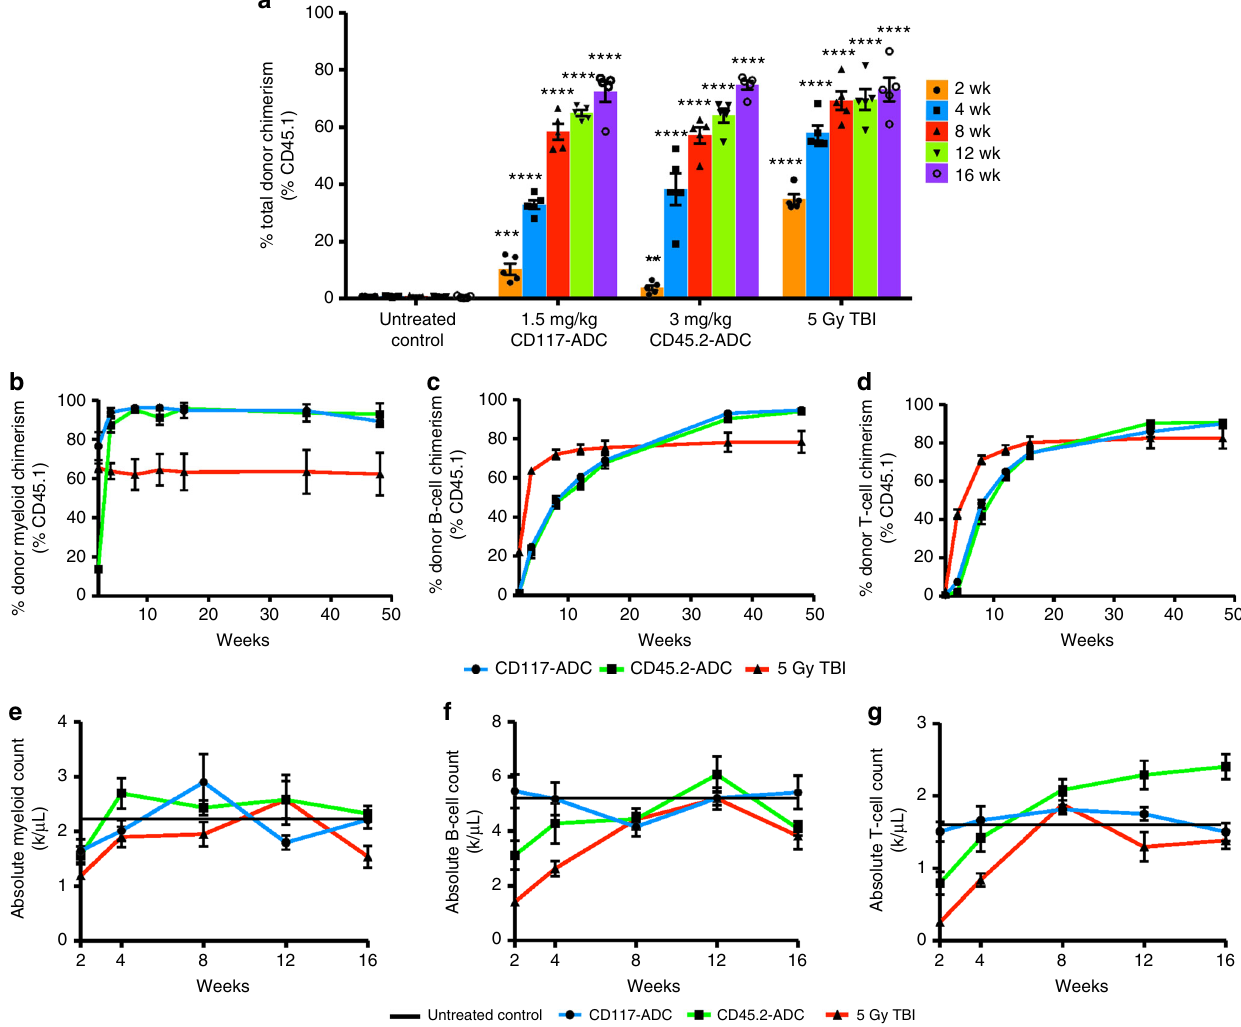
Fig. 3 CD117-ADC conditioning leads to comparable total multi-lineage engraftment as alternative conditioning regimens post WBM transplantation with improved engraftment kinetics. a CD117-ADC conditioning pre-WBM transplantation leads to comparable total peripheral blood chimerism as CD45.2- ADC and 5 Gy TBI conditioning. Robust multi-lineage donor engraftment with rapid donor granulocyte chimerism ( b ) and slower donor B-cell ( c ) and T-cell turnover ( d ). e – g No signi fi cant leukopenia observed post CD117-ADC treatment and WBM transplantation, as opposed to CD45.2-ADC and 5 Gy TBI conditioning with grossly normal absolute myeloid cells ( e ), absolute B-cells ( f ), and absolute T-cells ( g ). Data represent mean ± SEM ( n = 5 mice/group, assayed individually). Statistics calculated using unpaired t test; all data points signi fi cant as indicated vs. untreated control (** P < 0.01; *** P < 0.001; **** P <